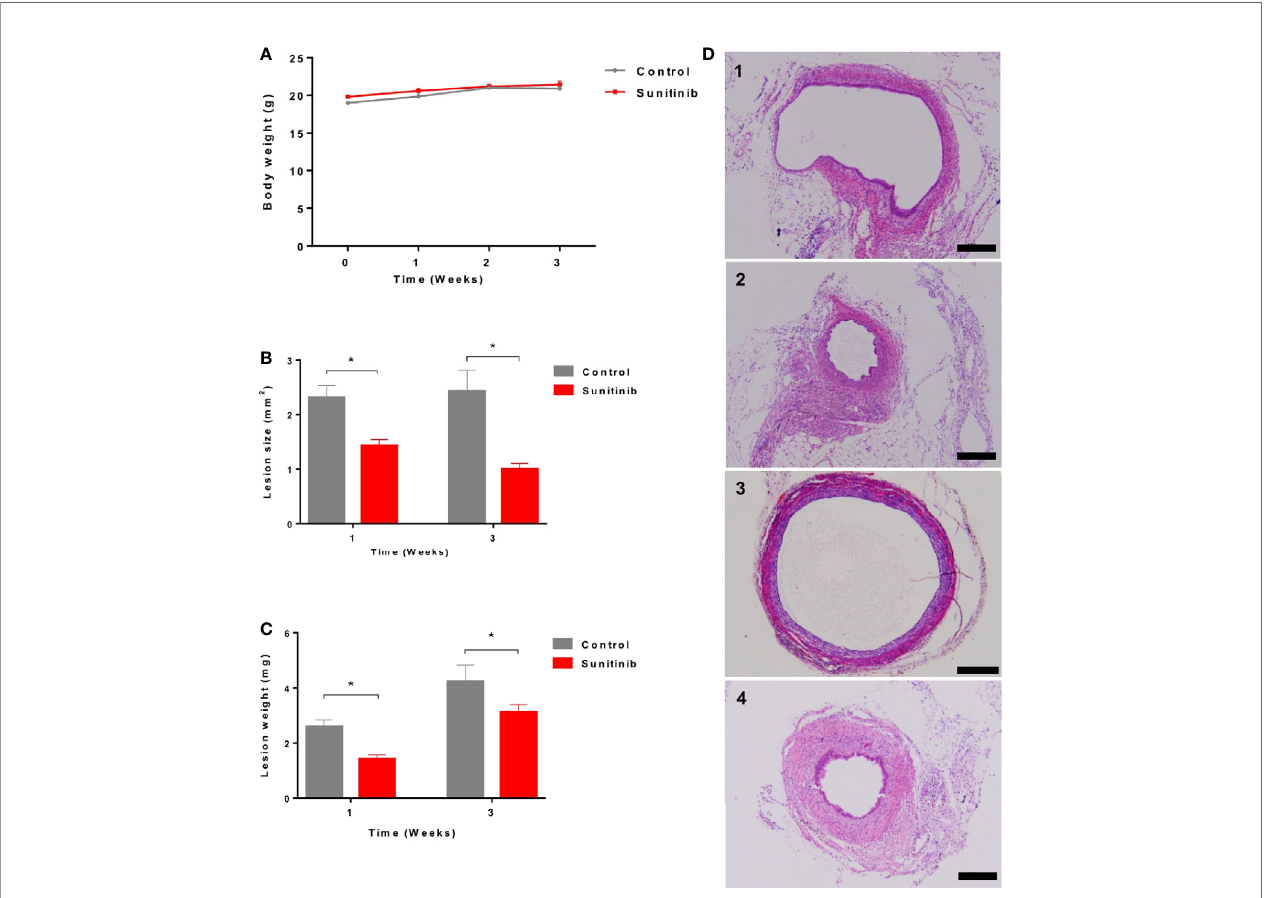
FIGURE 1 | Effects of Sunitinib on endometriosis lesions. (A) Changes to body weights during control and Sunitinib treatment. (B) Size of the endometriotic lesions after 1 and 3 weeks of treatment. (C) Weight of the endometriotic lesions after 1 and 3 weeks of treatment. Data are expressed as the mean ± SEM from 10 animals in each group, *p < 0.05. (D) Representative histology sections of the endometriotic lesions from control and Sunitinib groups. D1: endometriotic lesion after 1 week of control treatment; D2: endometriotic lesion after 1 week of Sunitinib treatment; D3: endometriotic lesion after 3 weeks of control treatment; D4: endometriotic lesion after 3 weeks of Sunitinib treatment, Scale bar: 200 m